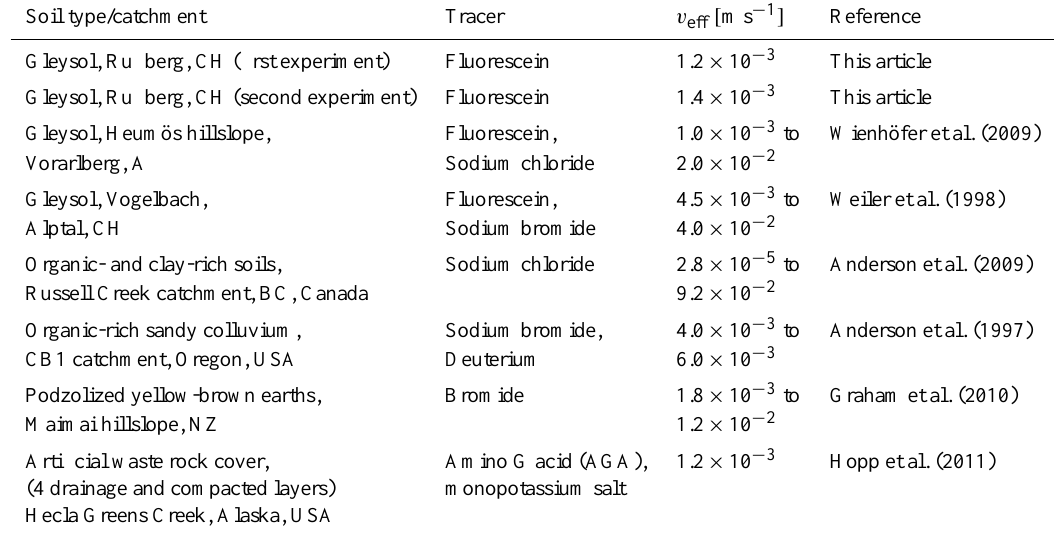
Table 4. Dominant lateral effective velocity ( v eff ) for subsurface storm flow (SSF) at different experimental